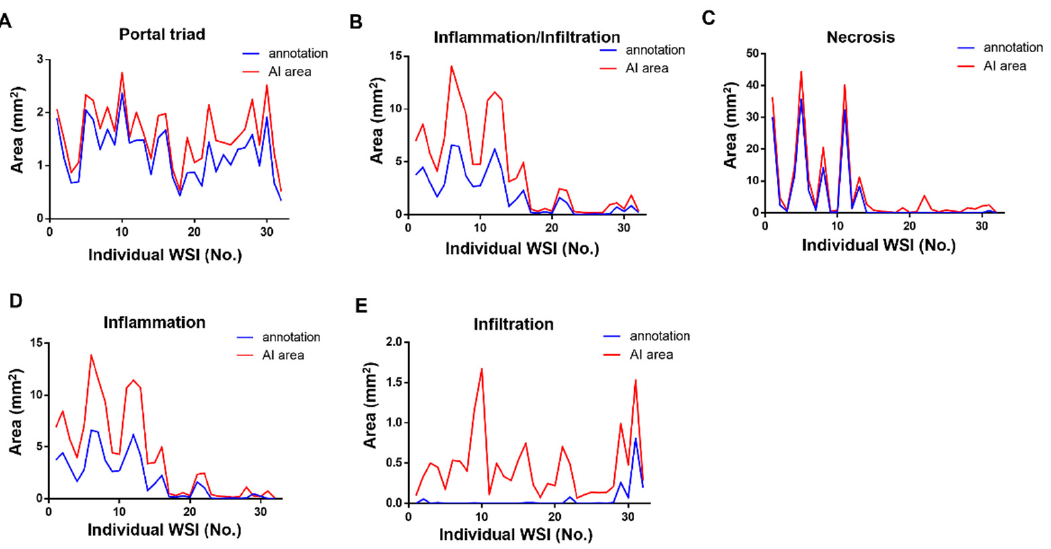
Figure 4. Comparison of the annotated and algorithm-predicted areas at the individual WSI level.